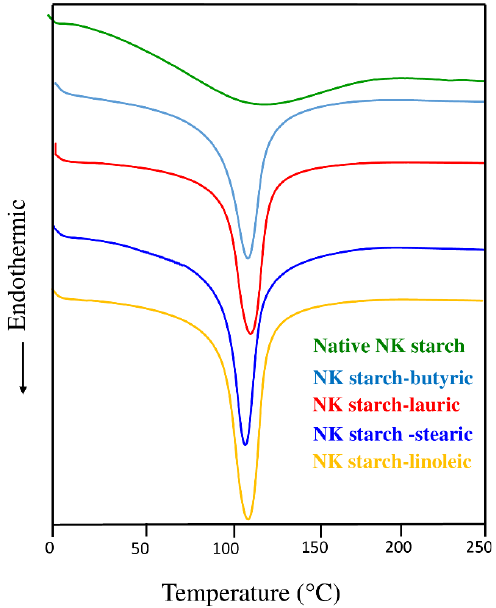
Figure 2. Differential scanning calorimeter (DSC) thermogram of native Noui Khuea (NK) starch and NK starch – lipid complexes with different fatty acid chain length.